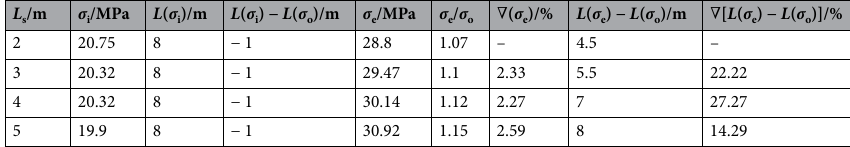
Table 6. Summary of dynamic change indexes of chamber surrounding rock under different L